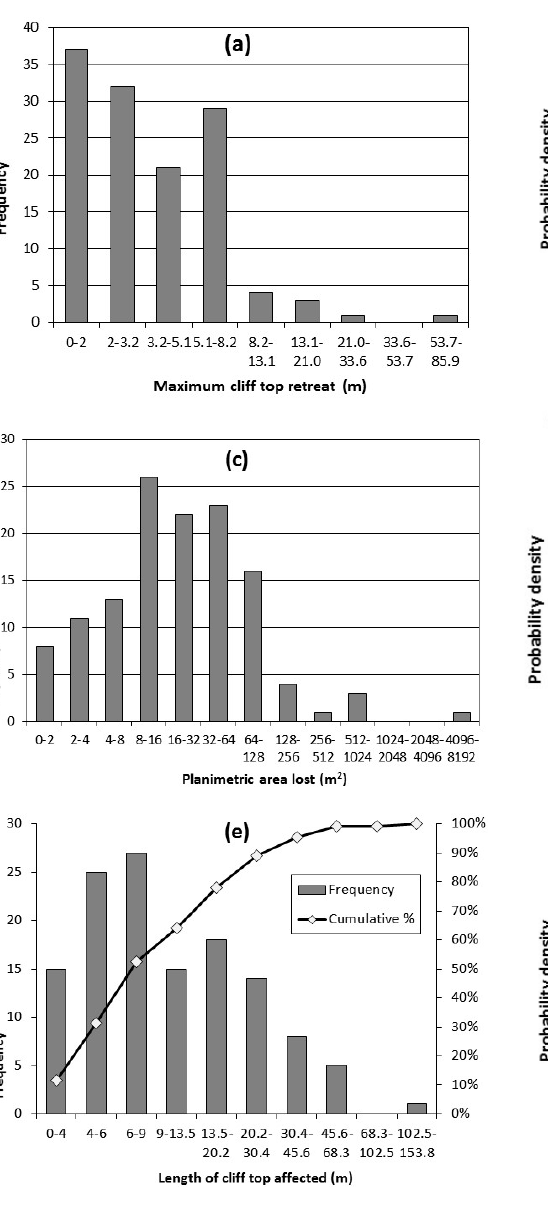
Figure 4. Maximum cliff top retreat ( a ) and kernel density estimation (KDE) ( b ). Planimetric area lost at the cliff top ( c ) and KDE without the large translational slide occurred in the northern end of the study area ( d ). Length of cliff affected ( e ) and KDE ( f ). Histograms with log based bins.